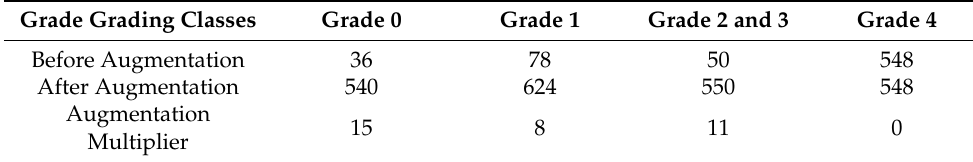
Table 4. Augmentation Process for Grade Grading